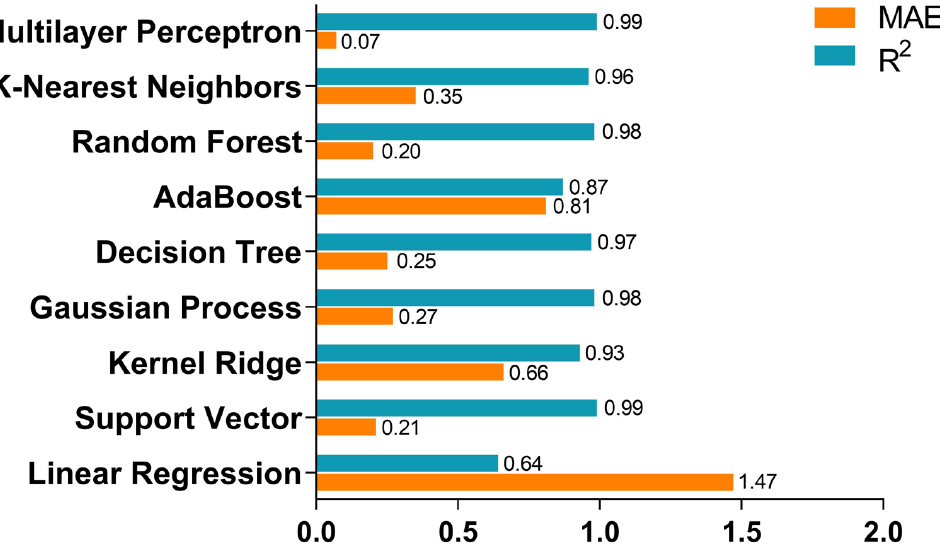
Figure 9. MAE losses and R 2 scores of each regression method using a five-feature dataset with an 80% training set size [101]. Copyright 2022 American Chemical Society.